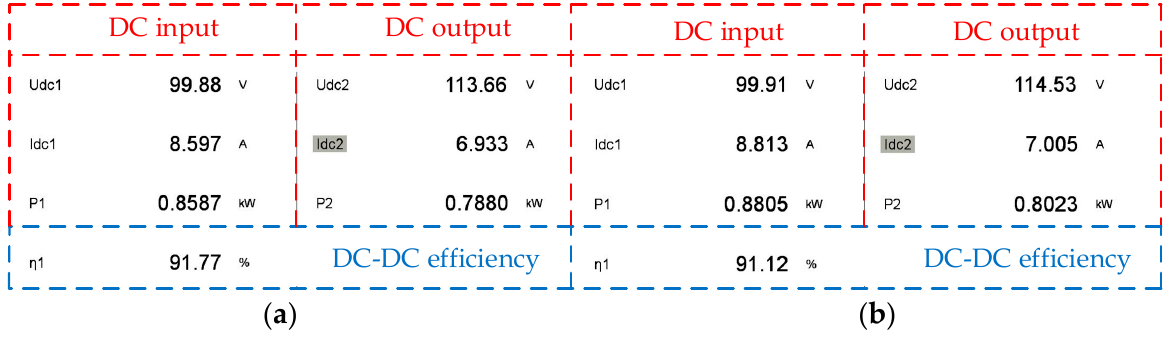
Figure 9. Power and efficiency test. ( a ) Air condition; ( b ) Seawater condition.